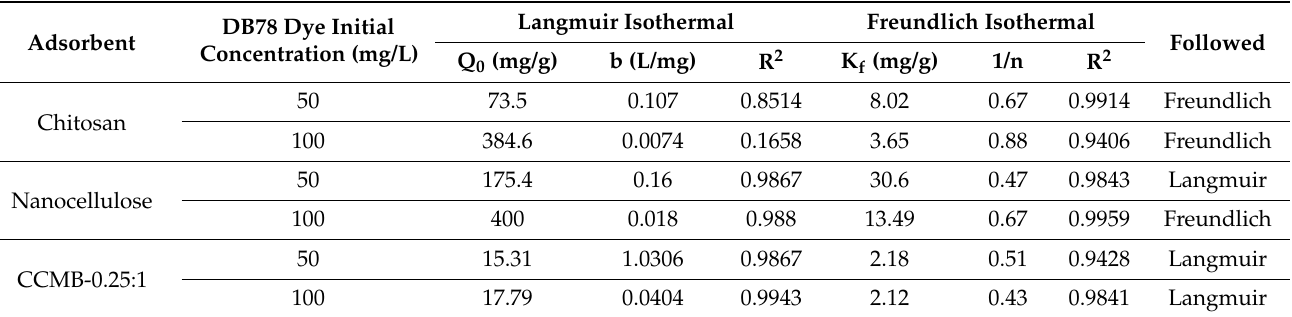
Figure 21. Langmuir adsorption isotherm for direct blue 78 dye removal using adsorbents ( a ) chitosan, ( b ) nanocellulose, and ( c ) CCMB-0.25:1. Table 3. Comparison of adsorption isothermal models for adsorbents (chitosan, nanocellulose, and